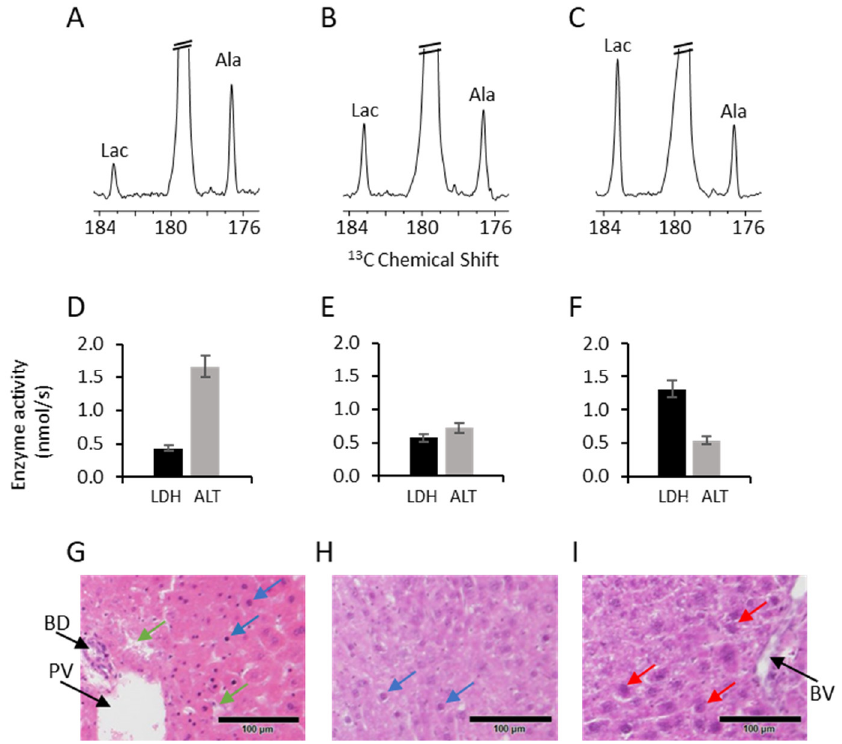
Figure 2. Typical 13 C spectra, enzyme activities, and histological preparations of precision-cut liver slices (PCLS) from a healthy mouse, and MRD2-KO mice with heterogeneous liver and HCC tumors. Panels A – C show 13 C spectra acquired at specific times following the injection of [1- 13 C]pyruvate to PCLS obtained from a normal mouse ( A , at 41 s), an aged MDR2 KO mouse with heterogeneous liver ( B , at 32 s), and an aged MDR2-KO mouse with a HCC tumor in the liver ( C , at 32 s). The spectra were processed with 5 Hz exponential multiplication, zero filled from 16,384 to 65,536 points, and baseline corrected. Ala, [1- 13 C]alanine; Lac, [1–13]lactate. The [1- 13 C]pyruvate hydrate signal at 179.35 is truncated. Panels D – F show the enzymatic activity of lactate dehydrogenase (LDH) and alanine transaminase (ALT) calculated from the spectra shown in A–C, respectively. The error bars show a 10% error which was estimated based on the signal-to-noise ratio in the spectra. Panels G – I demonstrates typical histological preparations from the PCLS that were perfused in the spectrometer and used for the metabolic study. The tissues were taken for histology many hours after harvesting—at the end of the study, which consisted of several hours of perfusion in the spectrometer. For this reason, the quality of the preparation for light microscopy is reduced. ( G ) Liver of a healthy mouse, with hepatic sinusoids (green arrows), and normal hepatocytes with small heterochromatic nuclei (blue arrows). ( H ) Heterogeneous liver of an aged MDR2-KO mouse, with hepatocytes with less heterochromatic nuclei (blue arrows). ( I ) A HCC tumor from the liver of an aged MDR2-KO mouse, with hepatocytes with large euchromatic nuclei (red arrows). Bar size is 100 μm; PV, portal vein; BD, bile duct; BV, blood vessel.